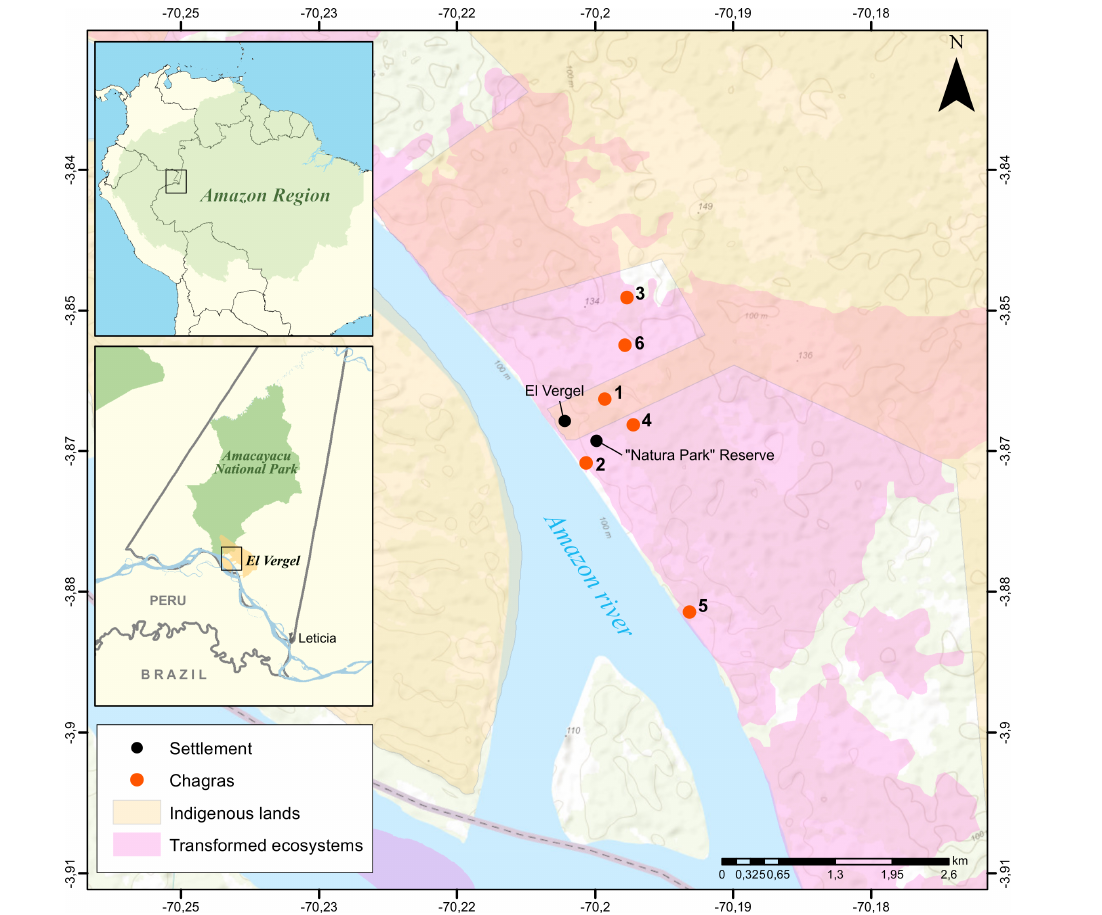
Fig. 2 . Ticuna chagras studied in the Indigenous Resguardo of El Vergel (Amazonas,